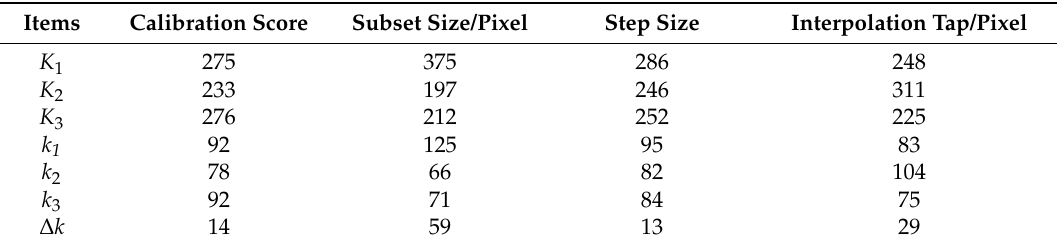
Table 3. Range analysis of strain calculation precision. The influential order of relevant factors for RTS was subset size > interpolation tap > calibration score > step